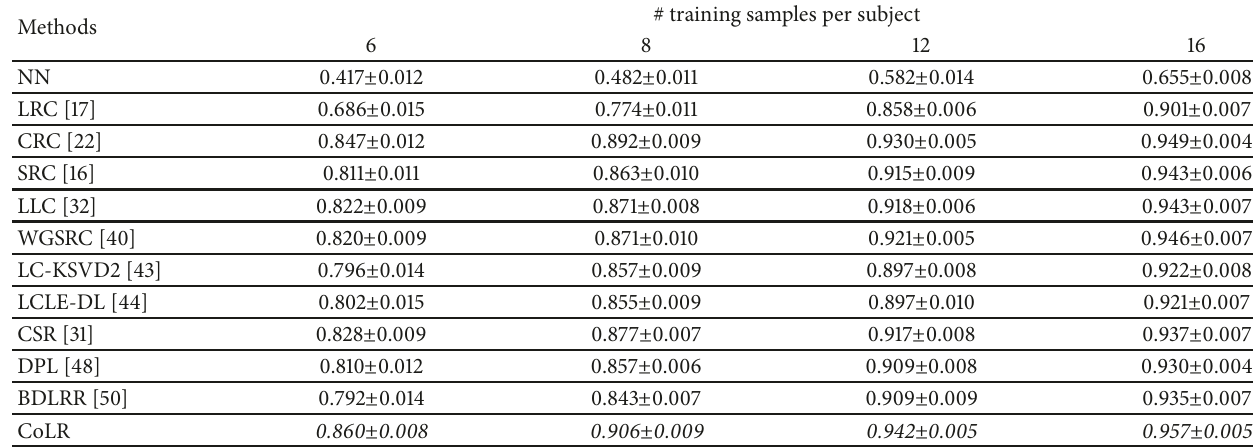
Table 5: Recognition rates on the Extended Yale B dataset with different number of training samples.